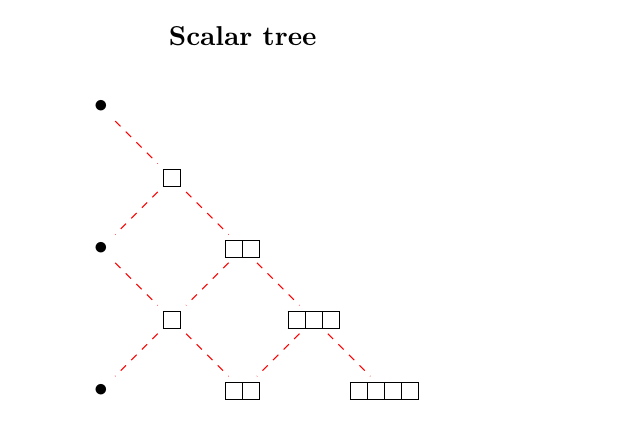
Figure 2 . The non-linear symmetries that can be realised on a scalar, and their space-time